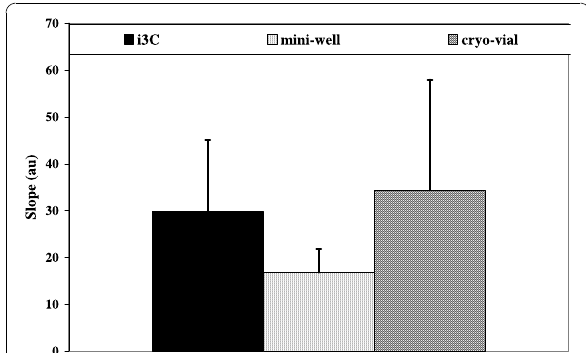
Figure 7 Fluorescein diacetate hydrolysis rates at 19 hours after thawing . For the evaluation of the metabolic recovery after the freezing - thawing cycle, the cells were stained by FDA and the linear slope FI(t) was calculated for each single cell by image analysis. The mean slopes for U937 cell groups that underwent the freezing - thawing cycle in the cryo-devices (at least 4 experiments for each cryo-device) are presented as mean ±